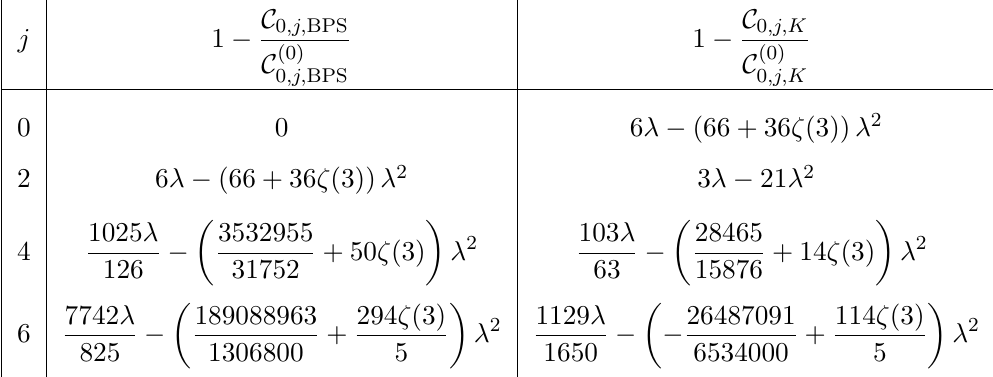
Table 2 . Two-loop three-point functions with a spin j operator and a